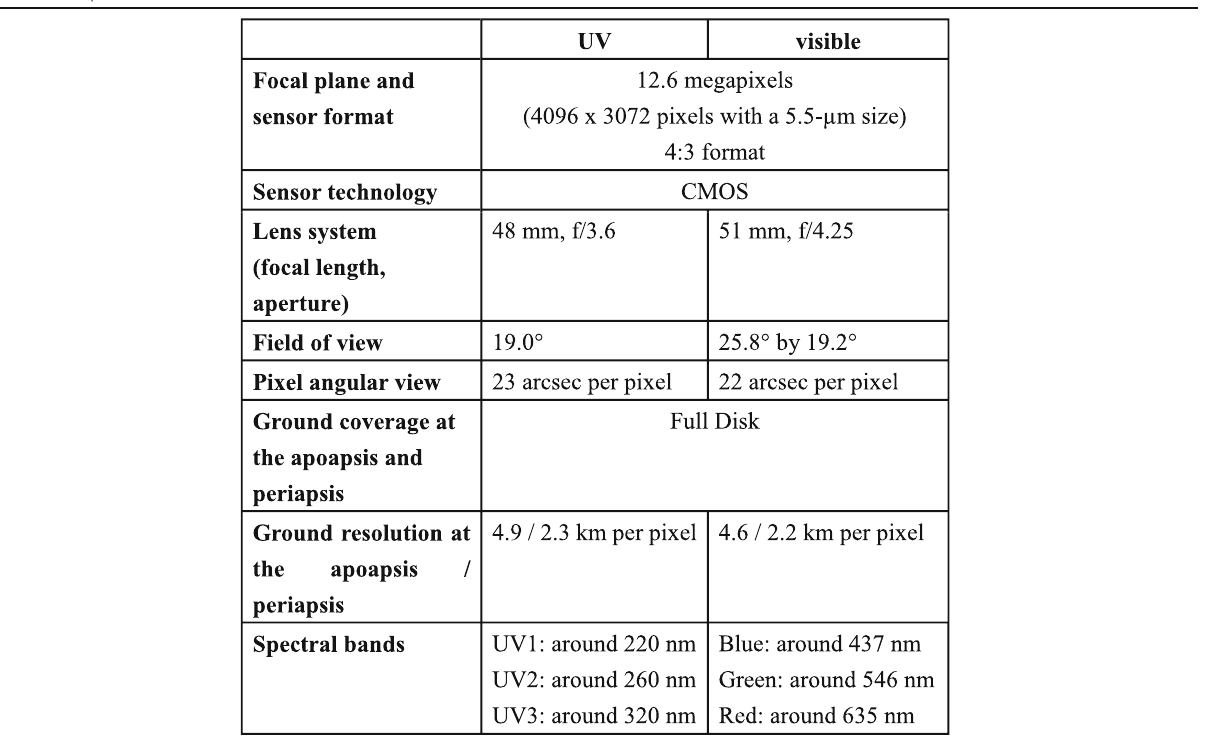
Table 2 Instrument specification of EXI onboard EMM. Where appropriate, a distinction between the UV and visible channels is made. Adapted from AlShamsi et al.